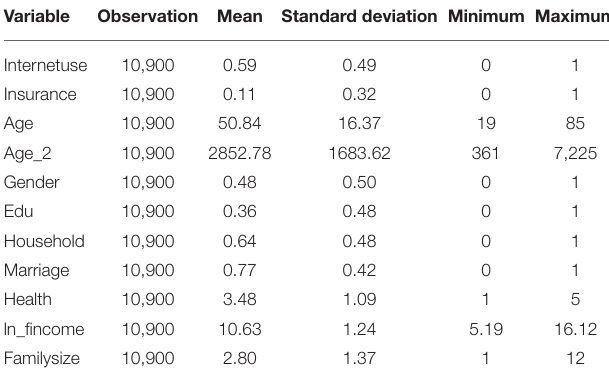
TABLE 1 | Variable definition and assignment. Variable Variable assignment